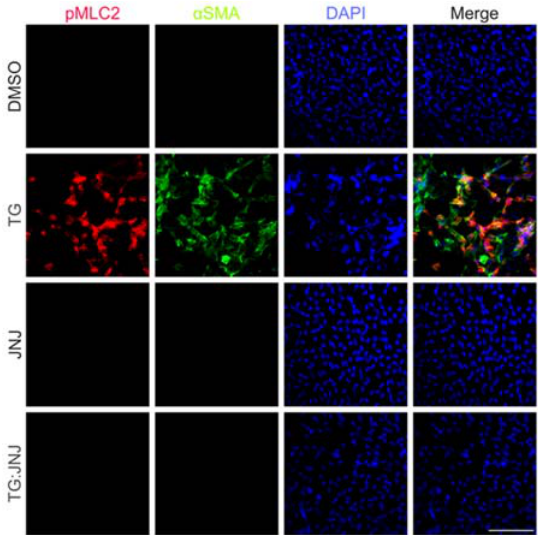
Figure 8. Localization of phosphorylated myosin light chain-2 at Ser18 (pMLC2) upon MMP9 inhibition. Rat LEC explants were treated with <5% DMSO, with 6 ng/mL TGF- β for 48 h (TG), with 20 µ M JNJ0966 (JNJ) for 48 h, or pretreated with 20 µ M JNJ0966 for 2 h followed by 6 ng/mL TGF- β for 48 h (TG:JNJ) ( n = 3 independent experiments where n ≥ 3 LECs per treatment were used for each experiment). Paraformaldehyde (PFA) fixed explants were stained for pMLC2 (red) and α SMA (green), and mounted with DAPI to visualize the nuclei. Images were acquired using Leica DM6 fluorescence microscope at 40 × . Scale bar, 100 µ m.